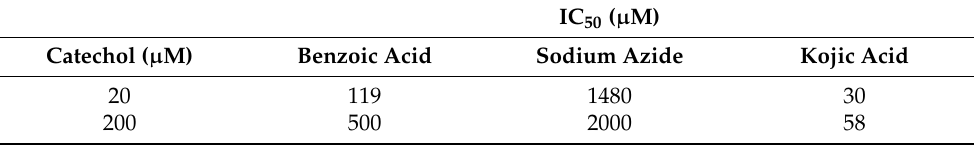
Table 2. IC 50 of competitive inhibition of tyrosinase immobilized on the carbon black paste of benzoic acid, sodium azide, and kojic acid in the presence of 20 µ M and 200 µ M catechol in 0.1 M phosphate buffer, pH 6.8. The applied potential was − 0.15 V vs. Ag/AgCl. Data are mean ± SD, n =